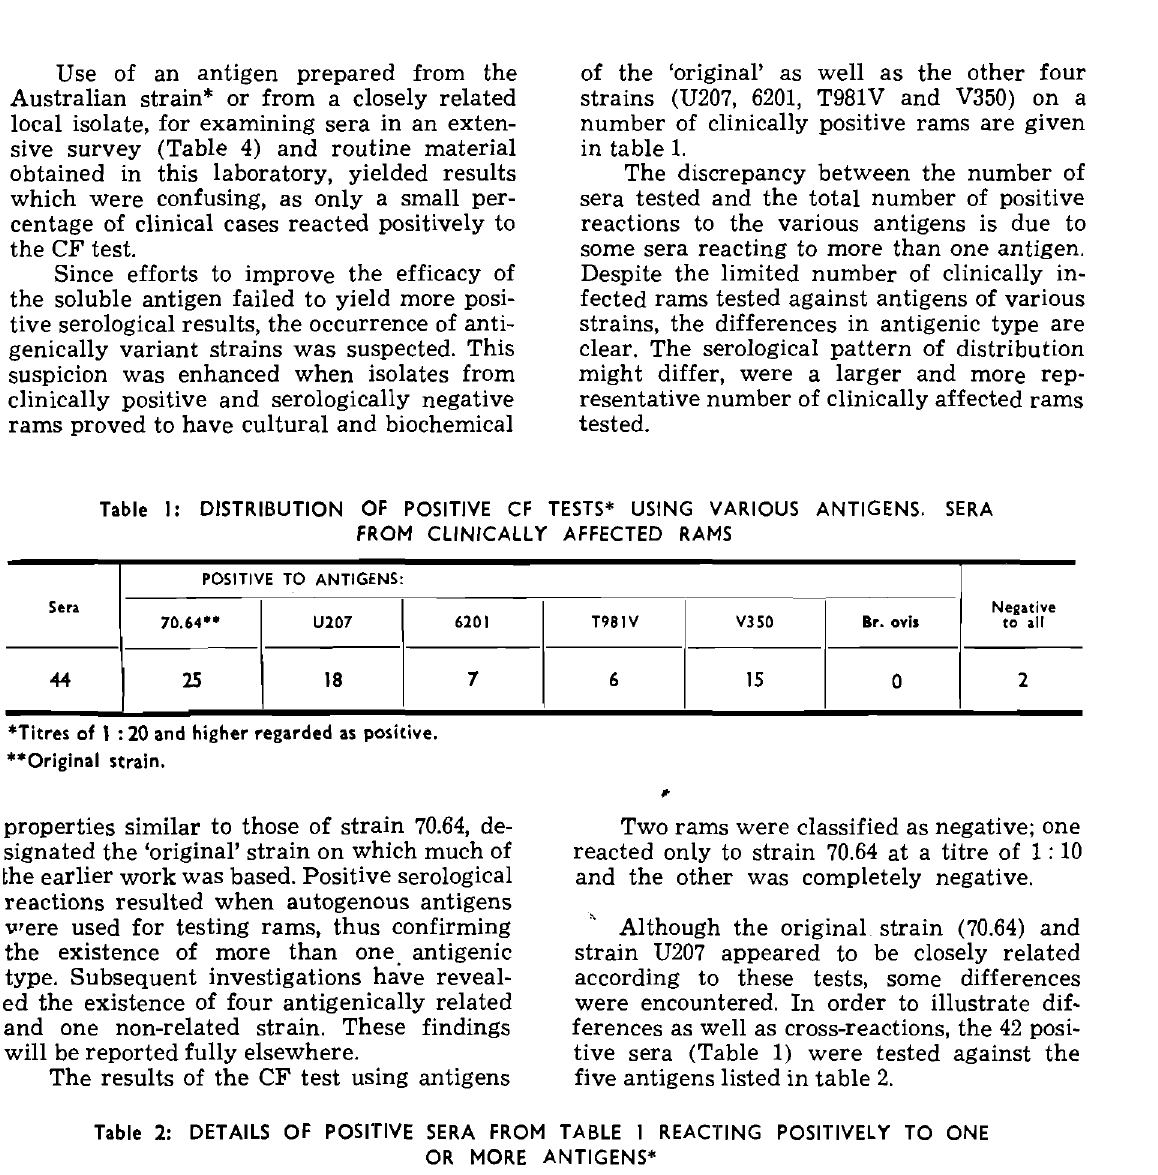
Table 2: DETAILS OF POSITIVE SERA FROM TABLE I REACTING POSITIVELY TO